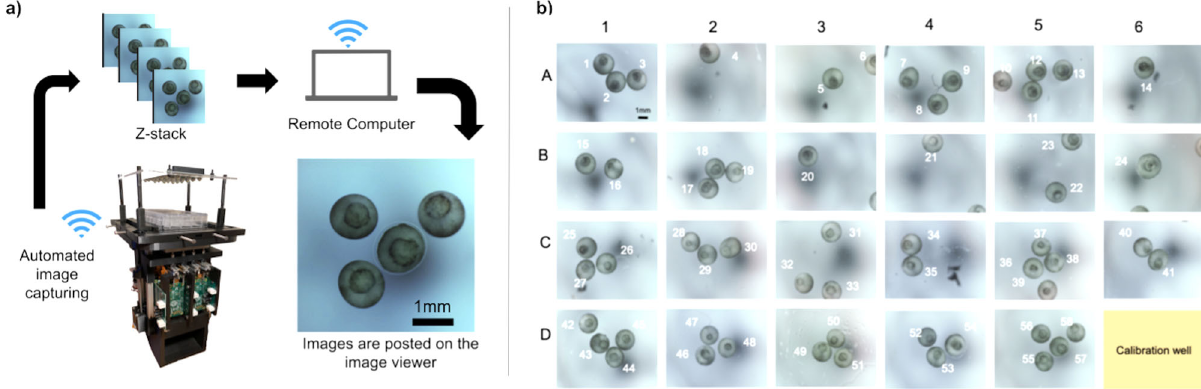
Fig. 5 System architecture. a The images are autonomously collected and wirelessly transferred to a remote computer for viewing or post processing. b Image of 23 wells observing 57 frog embryos.